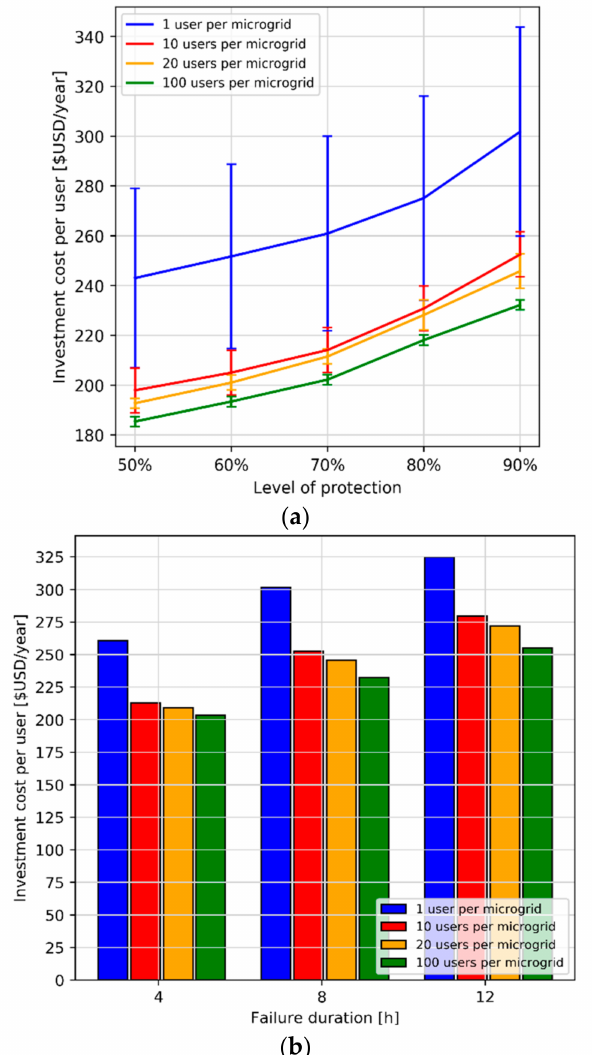
Figure 8. Investment cost per household as a function of ( a ) protection level for faults of 8 h duration and ( b ) duration of faults with 90% protection level (Case